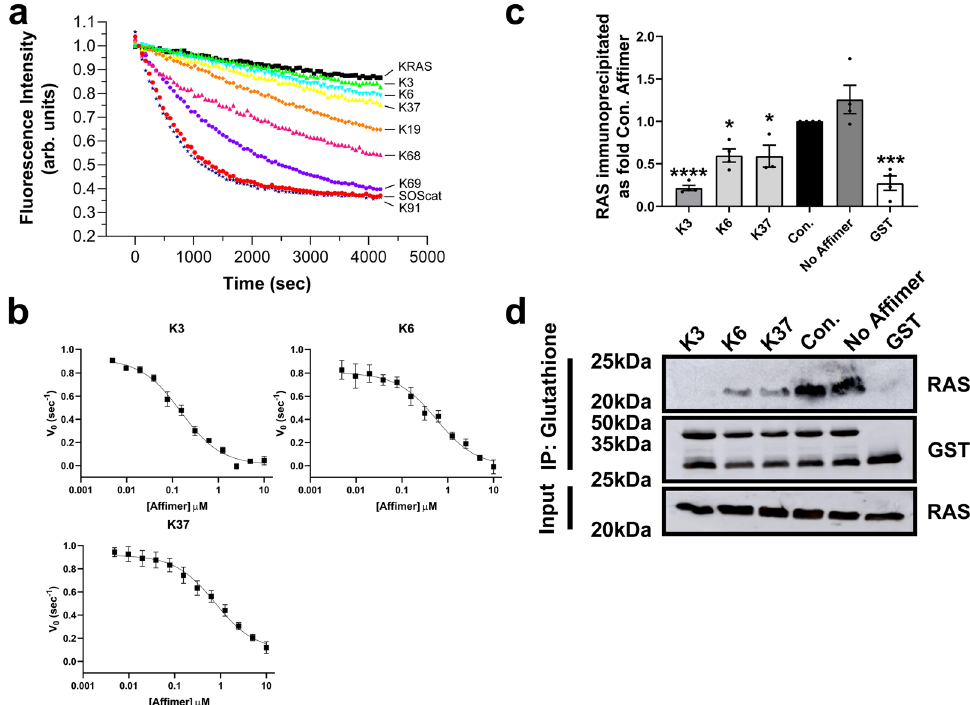
Fig. 1 Biochemical analysis of RAS-binding Af fi mers. a Nucleotide exchange assay shows 3 Af fi mers, K3 (green triangles), K6 (turquoise triangles), and K37 (yellow triangles), inhibit SOS1-mediated nucleotide exchange, whilst K19 (orange diamonds) and K68 (magenta triangles) show inhibition of intrinsic nucleotide exchange and K69 (purple hexagons) and K91 (navy stars) do not inhibit nucleotide exchange at 10 µ M. KRAS alone is shown as black squares and in the presence of SOS1 cat as red circles. b Af fi mers K3, K6, and K37 demonstrate dose-response inhibition of KRAS WT nucleotide exchange (Data fi tted to the Hill Model ([Af fi mer] vs. response (three parameters)), n = 3 independent experiments for K3 and K6 and n = 5 for K37). c Immunoprecipitation of KRAS with GST-RAF-RBD is inhibited by the RAS-binding Af fi mers, K3, K6, and K37 compared to control Af fi mer (Variable regions of AAAA and AAE) which does not differ from the no Af fi mer (PBS). GST alone does not pull down RAS (Quanti fi cation using ImageQuantTL; n = 3 independent experiments). d A representative Western blot of the pull-down experiment from c . Data are mean± SEM, One-way ANOVA with Dunnett ’ s post-hoc test * p = 0.0307 K6, p = 0.0439 K37, *** p = 0.0002 GST, **** p < 0.0001 K3. SOScat catalytic domain of SOS1 (Son of Sevenless). Con. Control Af fi mer, RBD RAS